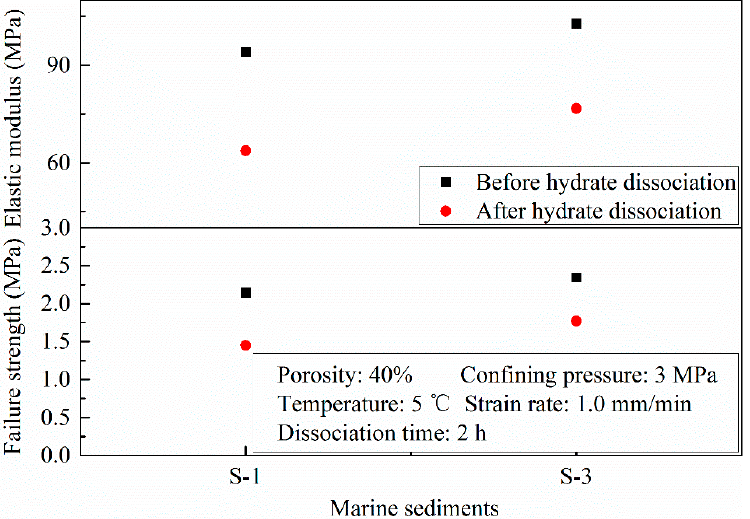
Figure 13. Elastic modulus and failure strength of HBMS formed by S-1 and S-3 marine sediments before and after hydrate dissociation.